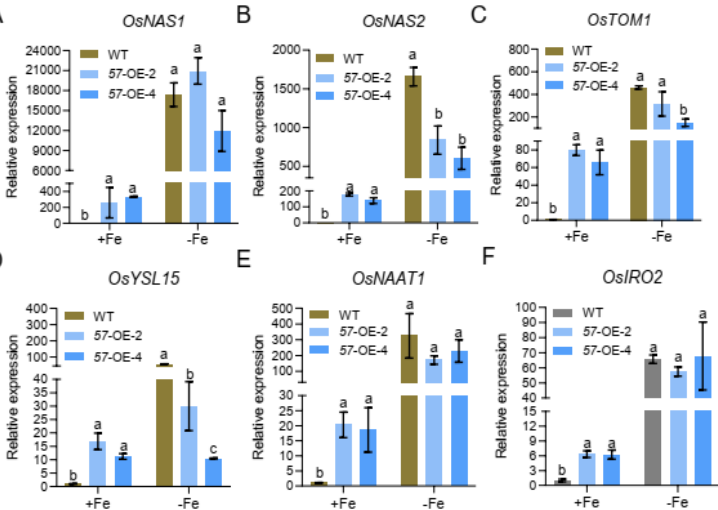
Figure 5. Expression of Fe homeostasis-related genes in the WT and osbhlh057-1 mutant. 12-day-old seedlings of the WT and osbhlh057-1 mutant were transferred to 1/2 Kimura B solution containing 2 μ M FeSO 4 or 0 μ M FeSO 4 for 4 days. The roots were sampled for gene expression analysis. OsActin1 was used as an internal control. Data are means ± SD of three biological replicates. Asterisks indicate significant differences between WT and osbhlh057-1 based on two-tailed Student’s t -test (* p < 0.05). We further investigated the gene expression changes of OsNAS1 , OsNAS2 , TOM1 , OsYSL15 , OsNATT1 , and OsIRO2 in OsbHLH057 -overexpressing transgenic plants. Com- pared to the WT, the expression levels of these genes were strongly upregulated in the roots of the OsbHLH057 -overexpressing lines under Fe-sufficient conditions (Figure 6). Under Fe-deficient conditions, whereas the expression levels of OsNAS2 and OsYSL15 were significantly downregulated in the OsbHLH057 -overexpressing lines compared with the WT, the expression levels of TOM1 , OsYSL15 , OsNATT1 , and OsIRO2 were no differ- ent between the WT and OsbHLH057 -overexpressing lines, except that OsTOM1 expres- sion was lower in the OsbHLH057 -OE-4 than in the WT (Figure 6). These results indicate that OsbHLH057 positively regulates the expression of many Fe homeostasis-related genes, at least under Fe-sufficient conditions.